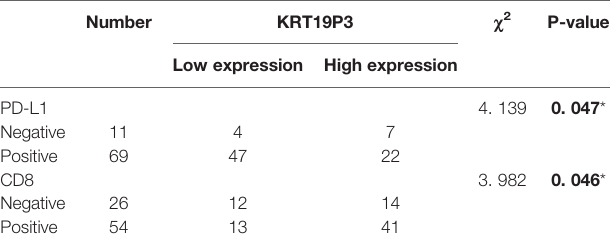
TABLE 1 | The relationship between KRT19P3 and PD-L1, CD8 in BC tissues. Number KRT19P3 c 2